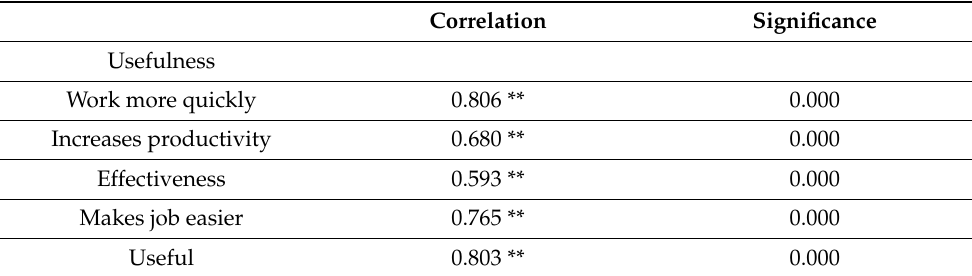
Table 6. Validity